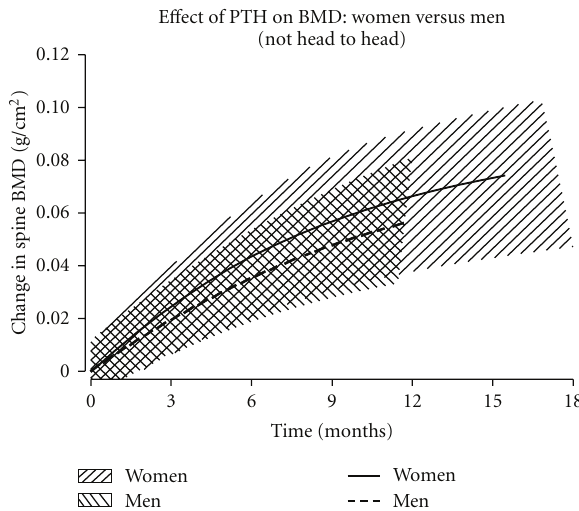
Figure 1: Changes in lumbar spine bone mineral density with teriparatide 20 µ g daily. Although the figure does not show a head- to-head comparison, the increase in bone mineral density in men over the 11 months of the trial by Orwoll et al. tracks closely along the trajectory in bone mineral density women over the same period of time in the trial of Neer et al. (from Satterwhite et al. [26]).